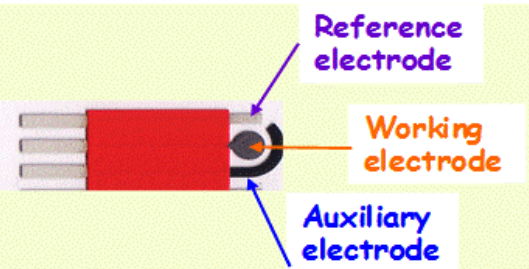
Figure 1. Design of a disposable and portable screen printed electrode (with reference, working and auxiliary electrodes on the same substrate) (IMAGES, Perpignan,